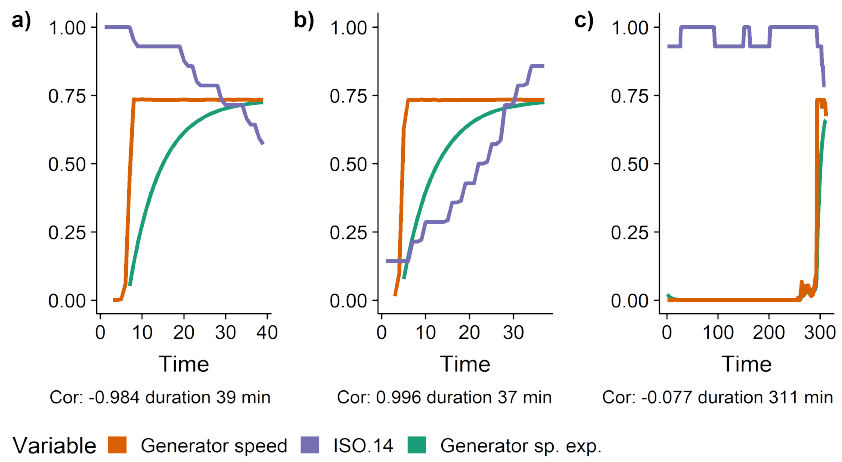
Figure 8. Boosting examples with disparate spearman correlation values between ISO.14 and smoothed generator speed. ( a ) Positive correlation. ( b ) Negative correlation. ( c ) No correlation.